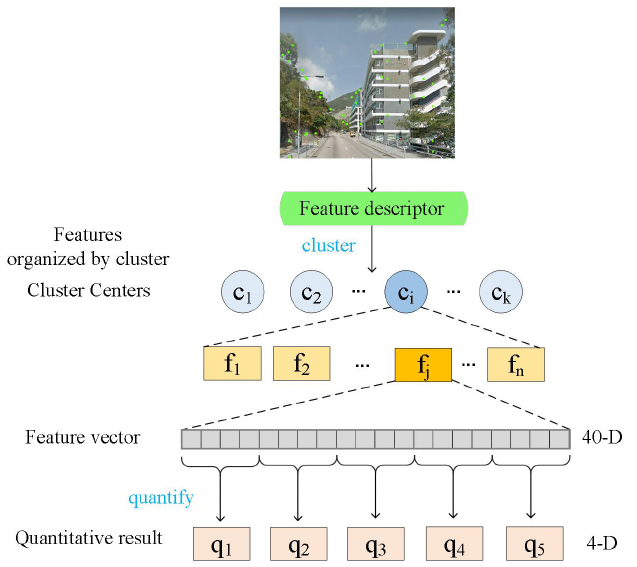
Figure 6. Inverted index and product quantization schematic